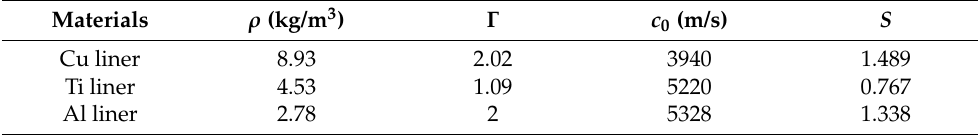
Table 3. Main parameters of Cu, Ti and Al liner materials.